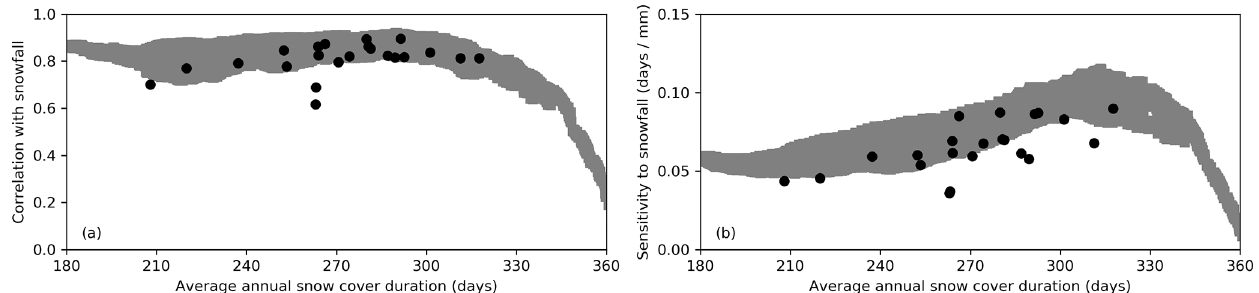
Figure 6. (a) Correlations between annual snow cover duration and snowfall amount in ESM-SnowMIP models (circles) and 2PM (grey band) at Weissfluhjoch. (b) Sensitivity of Weissfluhjoch snow cover duration to snowfall, expressed as increase in days of annual snow cover per millimetre of increase in annual snowfall found by linear regression.